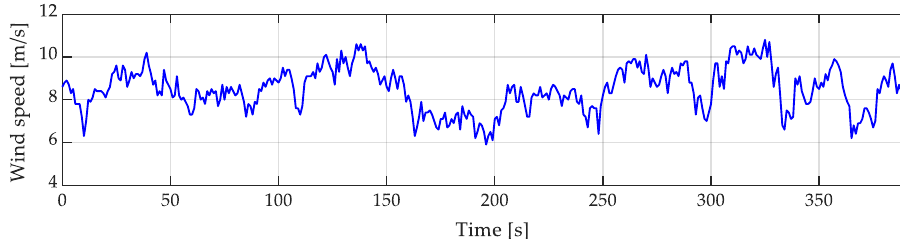
Figure 9. Wind profile introduced to the VSWT model.